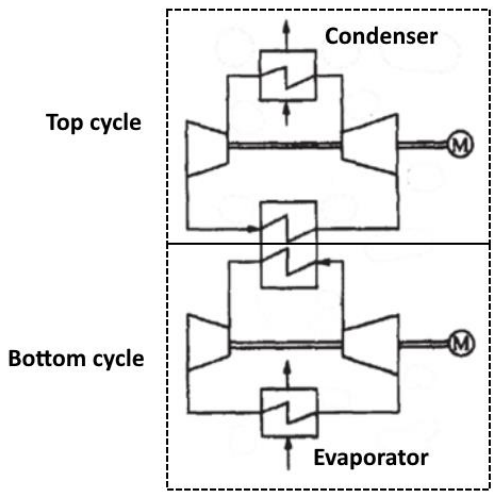
Figure 11. High-temperature heat pump [30].